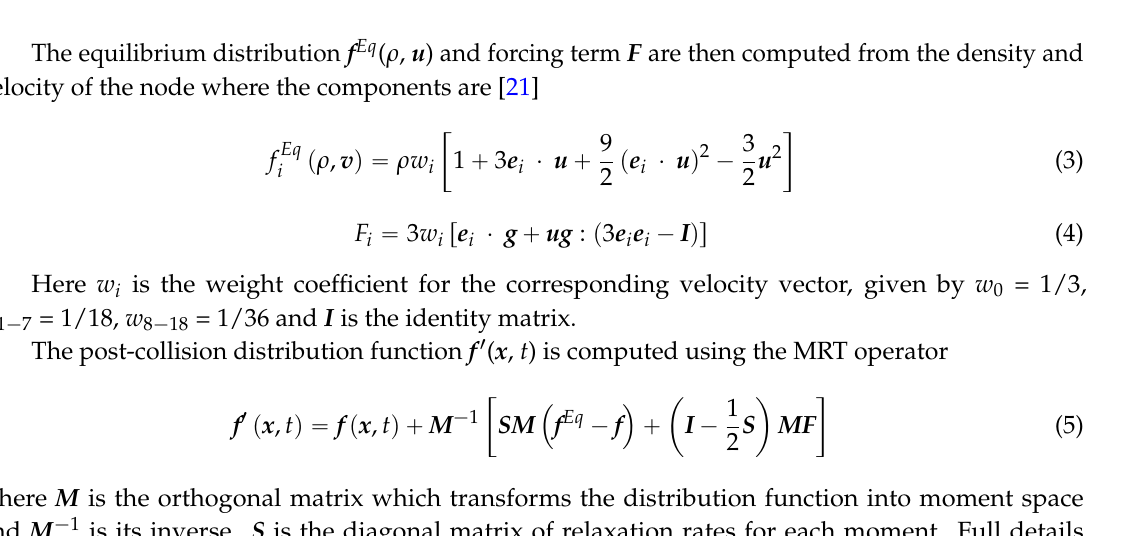
Figure 1. The 19 velocity components of the D3Q19 scheme.